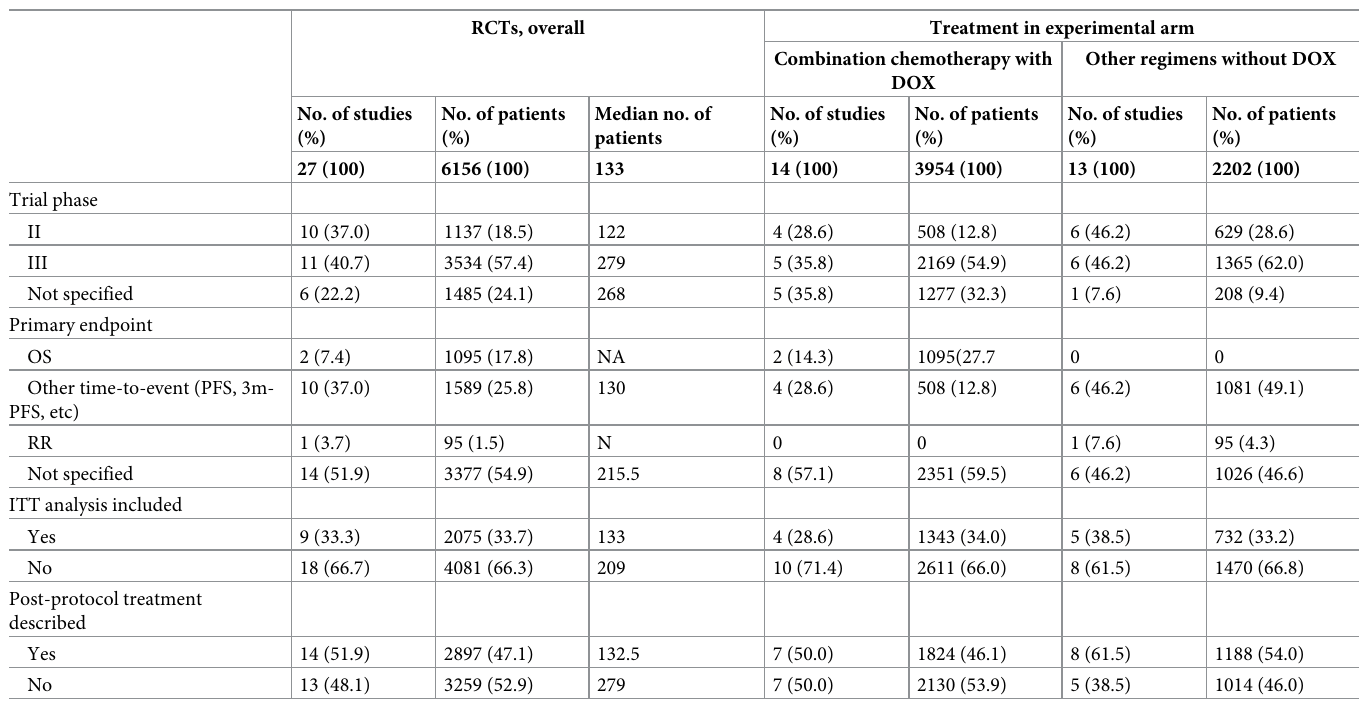
Table 1. Characteristics of